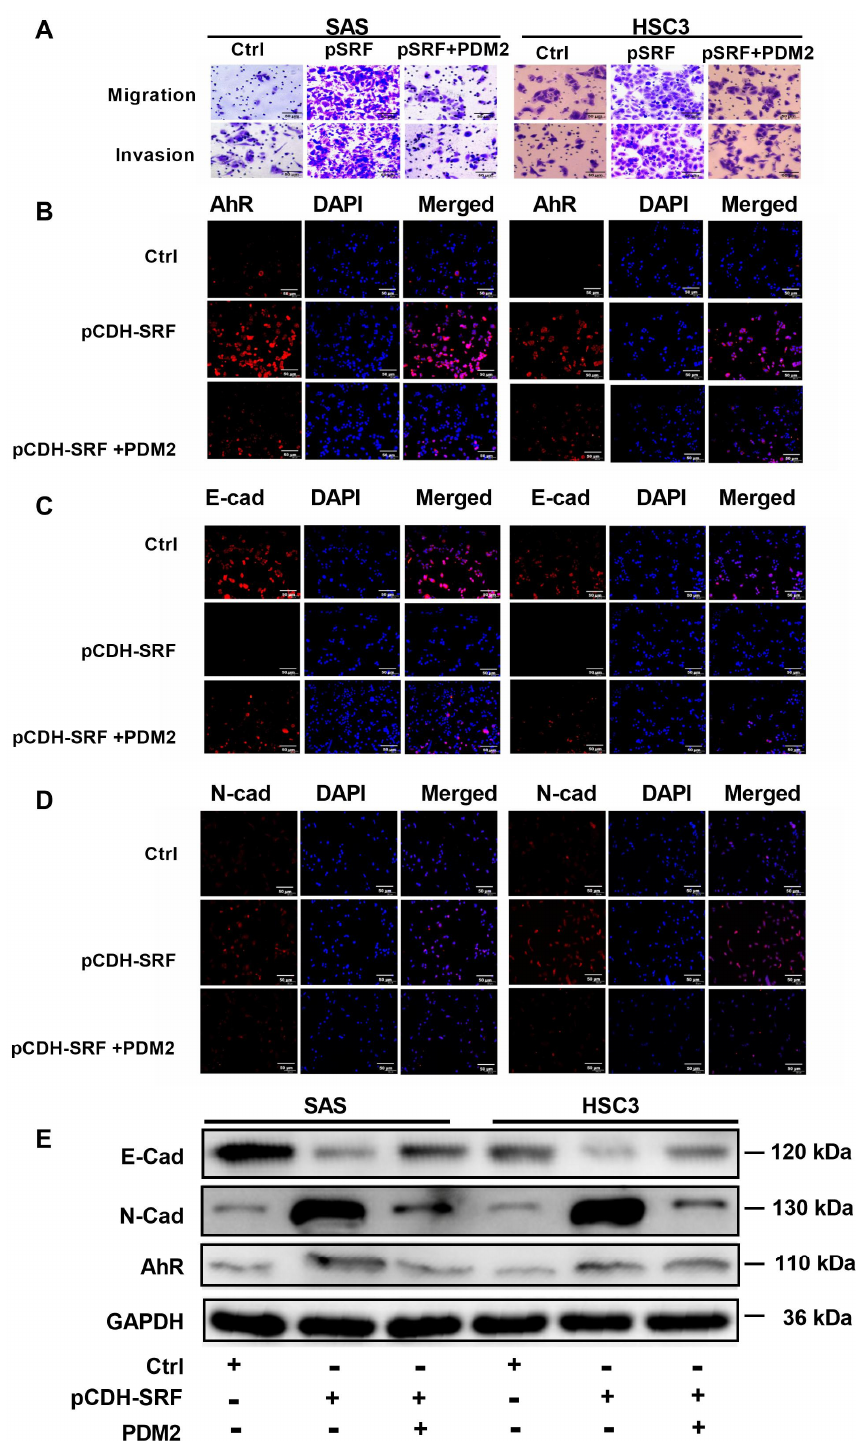
Figure 8. AhR is involved in the function of SRF in carcinogenesis. ( A ) Migration and invasion assays on SAS and HSC-3 cells after adding the AhR inhibitor PDM2. Immunofluorescence staining of AhR ( B ), E-cadherin ( C ), and N-cadherin ( D ) in SAS and HSC-3 cells after adding PDM2. The scale bar is shown in lower-right corner. ( E ) Western blotting results of AhR, E-cadherin, and N-cadherin in SAS and HSC-3 cells after adding PDM2. Original western blots are shown in Figure S9. AhR, aryl hydrocarbon receptor; E-cad, E-cadherin; N-cad, N-cadherin; OSCC, oral squamous cell carcinoma; PDM2, AhR inhibitor; SRF, serum response